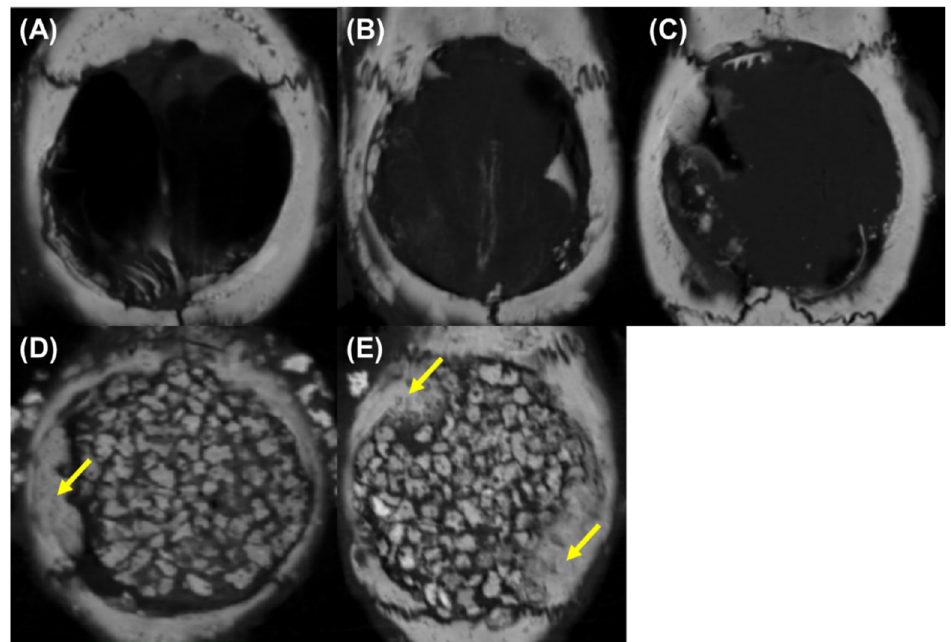
Figure 12. Reconstructed image of CT ( A ) defect group, ( B ) GS group, ( C ) GS + DFAT group, ( D ) α - TCP/GS group, and ( E ) α -TCP/GS + DFAT group α -TCP/GS, composite gelatin sponge; GS, gelatin scaffolds; and DFAT, dedifferentiated fat cell. The yellow arrows indicate to new bone.